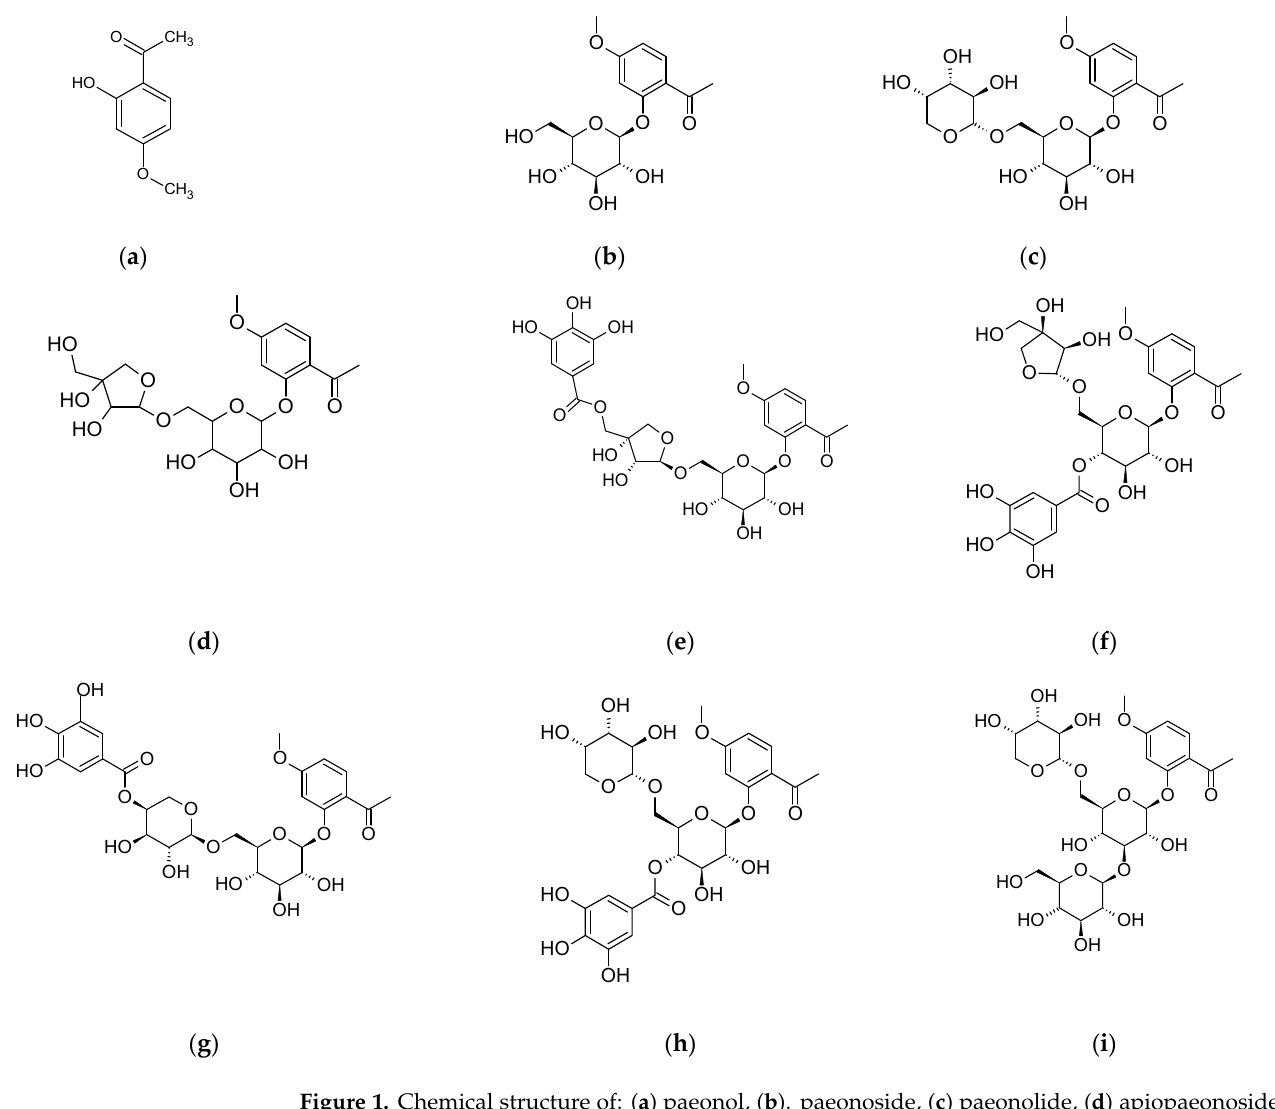
Figure 1. Chemical structure of: ( a ) paeonol, ( b ). paeonoside, ( c ) paeonolide, ( d ) apiopaeonoside, ( e ) suffruticoside A, ( f ) suffruticoside B, ( g ) suffruticoside C, ( h ) suffruticoside D, ( i ) suffruticoside E.